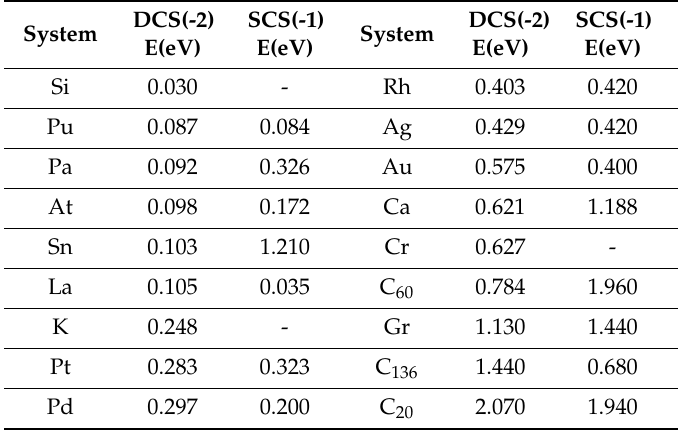
Table 2. Comparison of the activation energy barrier reduction, E(eV), between the doubly-charged systems, DCS(-2), and the singly-charged systems,